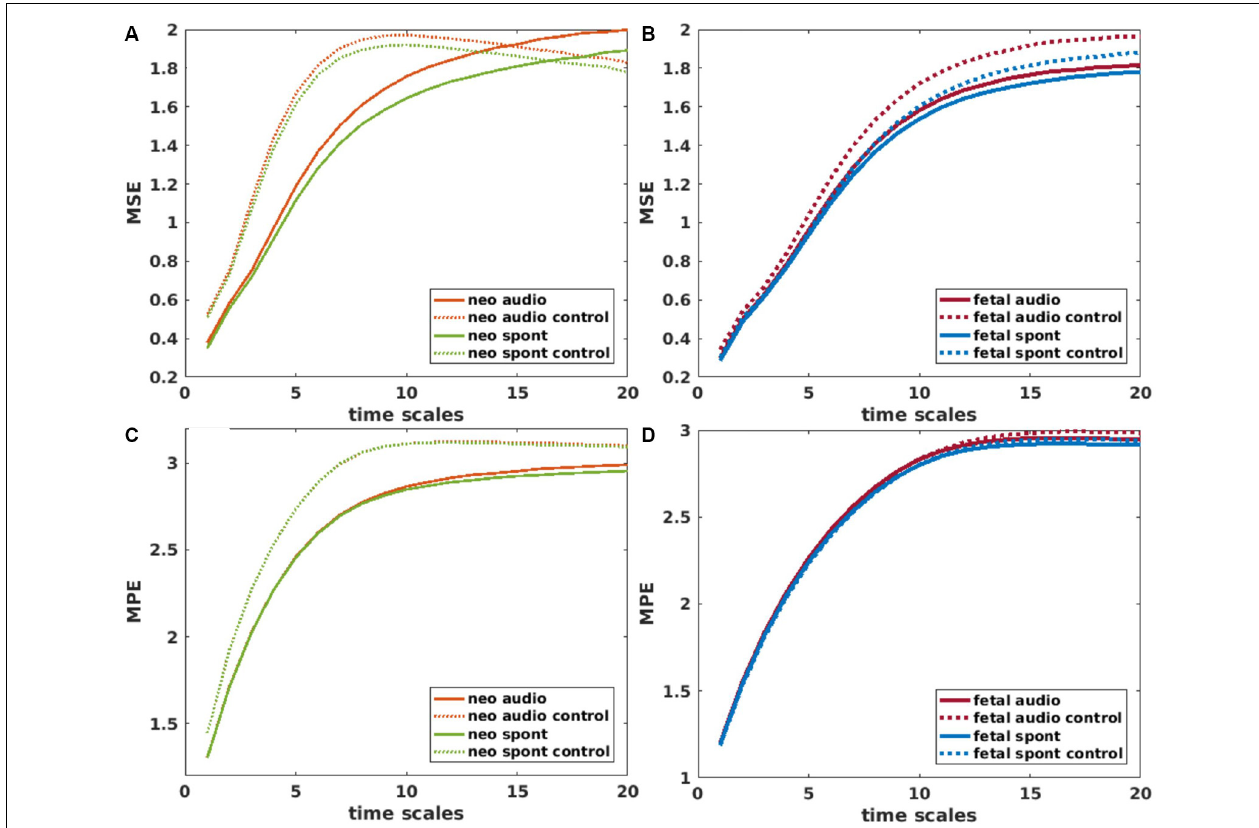
FIGURE 4 | Mean values of Multiscale Entropy (MSE) over time scales 1–20 for neonatal (A) and fetal (B) recordings. Solid lines represent brain channels and dotted lines control channels for recordings with and without auditory stimulation (audio/spont). Corresponding plots for Multiscale permutation entropy (MPE) in (C,D) . Values for control channel (audio and spont) in (C) are